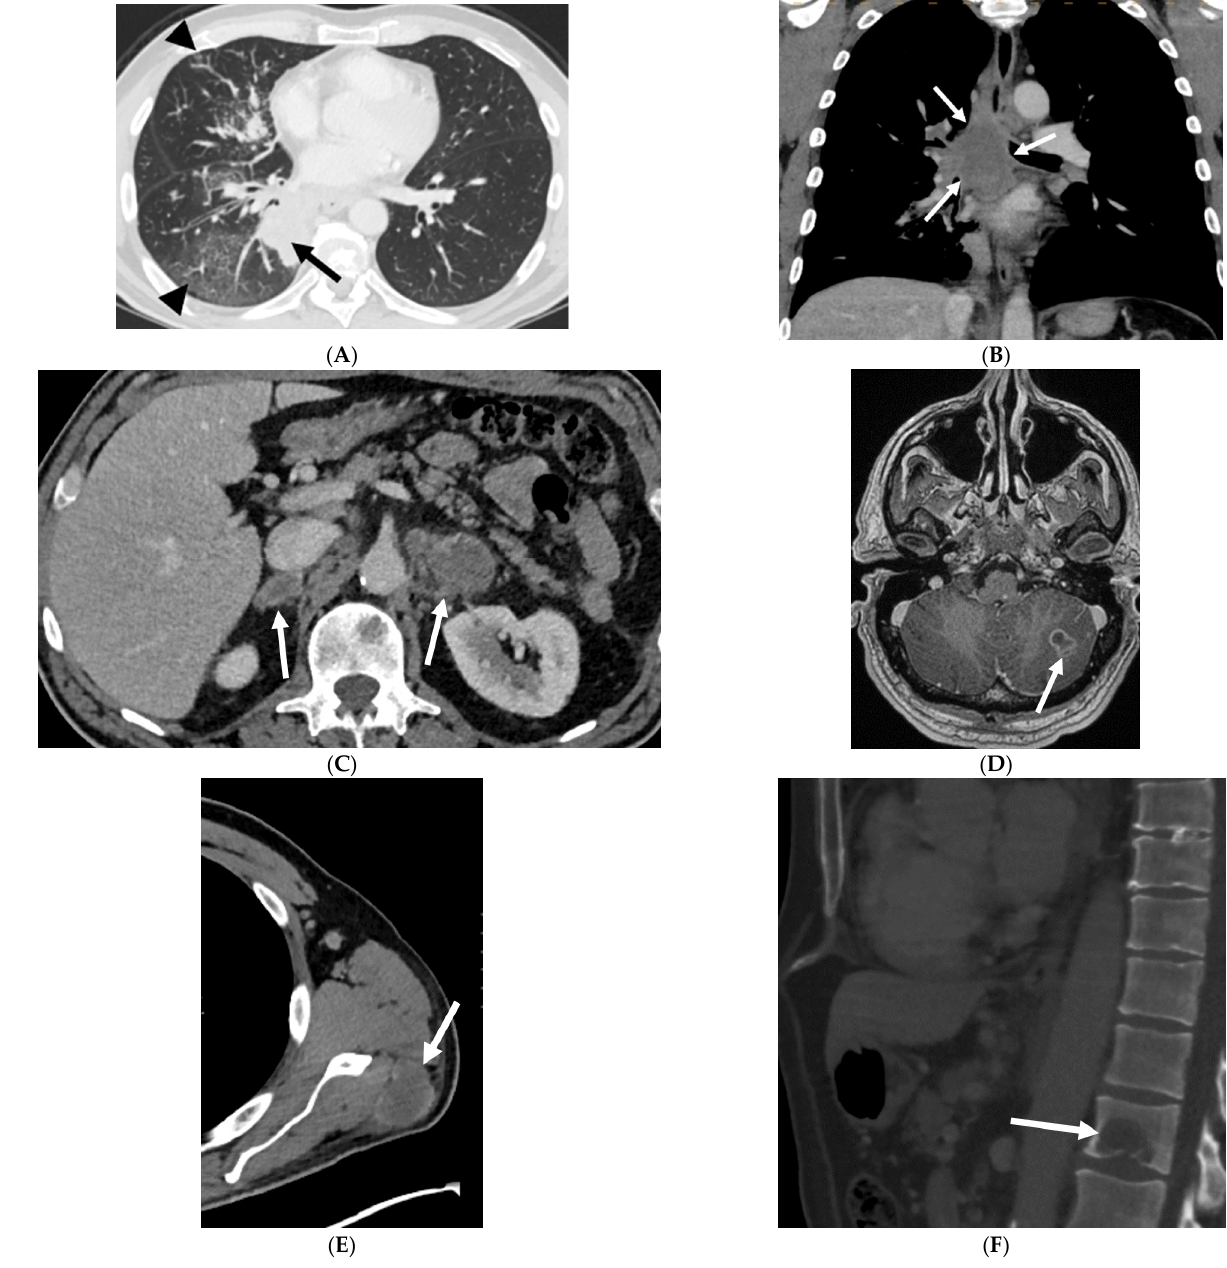
Figure 2. Representative imaging features in a 64-year-old male prior smoker with G12C KRAS NSCLC. Pretreatment CT images show a solid mass in the right lower lobe ( A , black arrow) and associated septal and peribronchial thickening consistent with lymphangitic carcinomatosis ( A , black arrowheads). There was extensive mediastinal and hilar lymphad- enopathy ( B , white arrows), bilateral adrenal metastases ( C , white arrows), brain metastasis ( D , white arrow), soft tissue metastasis ( E , white arrow), and a lytic osseous metastasis of the first lumbar vertebral body ( F , white arrow).